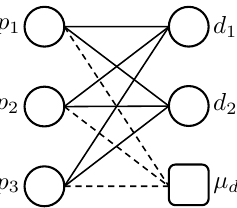
Figure 2. Example of a complete bipartite graph B = ( U , E ) .